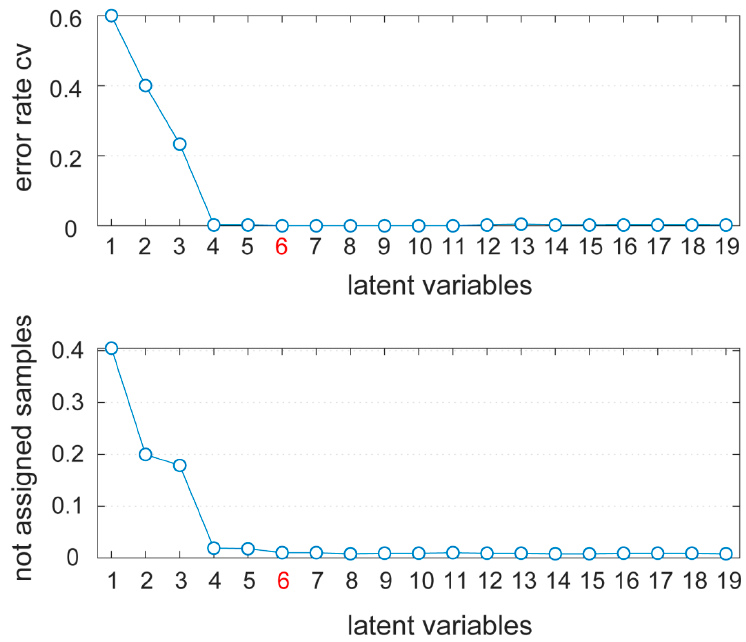
Figure 6. Error rate ( a ) and not assigned samples ( b ) as a function of latent variables calculated in the partial least squares-discriminant analysis (PLS-DA) model. Six latent variables (LVs) was the optimal number, marked in red, with 0.0099% of not assigned samples.